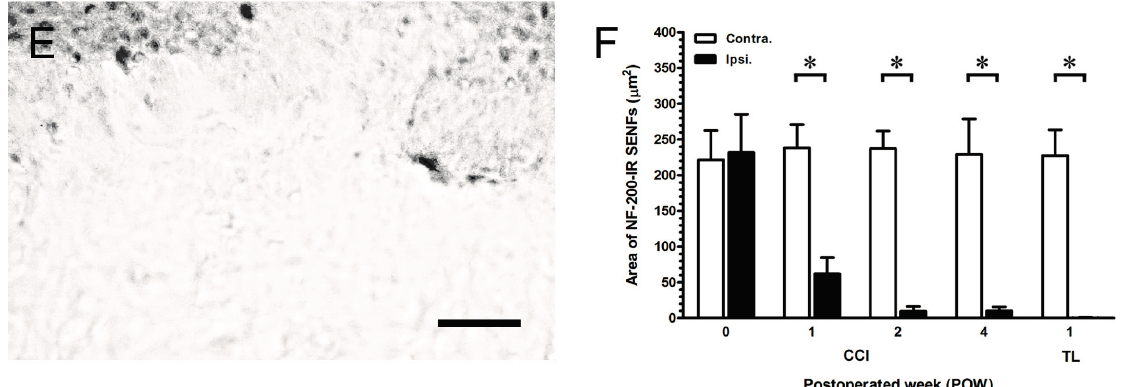
Figure 2. Neurofilament 200 (NF-200)-immunoreactive (IR) subepidermal nerve fibers (SENFs) in dermis under the influences of nerve compression injury. The ipsilateral sides of footpad skin from ( A ) sham-operated surgery, ( B – D ) CCI, and ( E ) TL were immunostained with antibody against NF-200. ( A ) Normal NF-200-IR SENFs exhibited abundant thick dermal fiber trunks (blue arrow), horizontally terminated around the epidermal-dermal junction (blue curve); Sequential changes of dermal expression after CCI were shown at ( B ) POW 1, ( C ) POW 2 and ( D ) POW 4, and thin NF-200-IR SENFs were revealed with irregular linear forms (blue arrowhead); ( E ) TL induced the complete fiber loss of NF-200-IR SENFs in dermis at POW 1. Scale bar = 25 μ m; and ( F ) The areas of NF-200-IR SENFs were quantified as the mean ± SD ( n = 5 at each time points after CCI, n = 5 at POW 1 after TL). Each bar of values showed in the contralateral sides (Contra., open bars) and ipsilateral sides (Ipsi., filled bars). Student’s t test was applied to examine the differences between the Contra. and Ipsi. at the same time points. * p < 0.05,